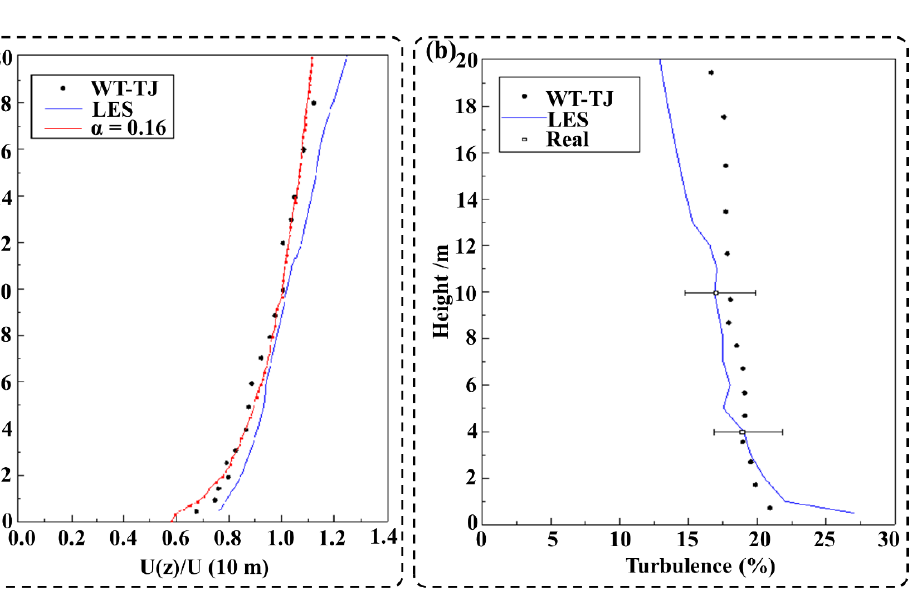
Figure 6. Average wind speed vector diagram of flow field: ( a ) overall flow field; ( b ) TTU model.